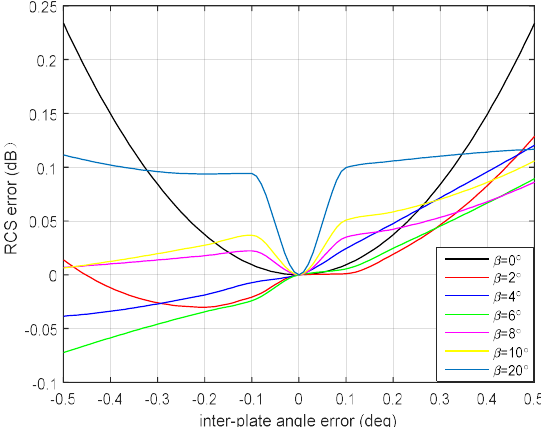
Figure 9. The effect of interplate angle error on the RCS at different bistatic